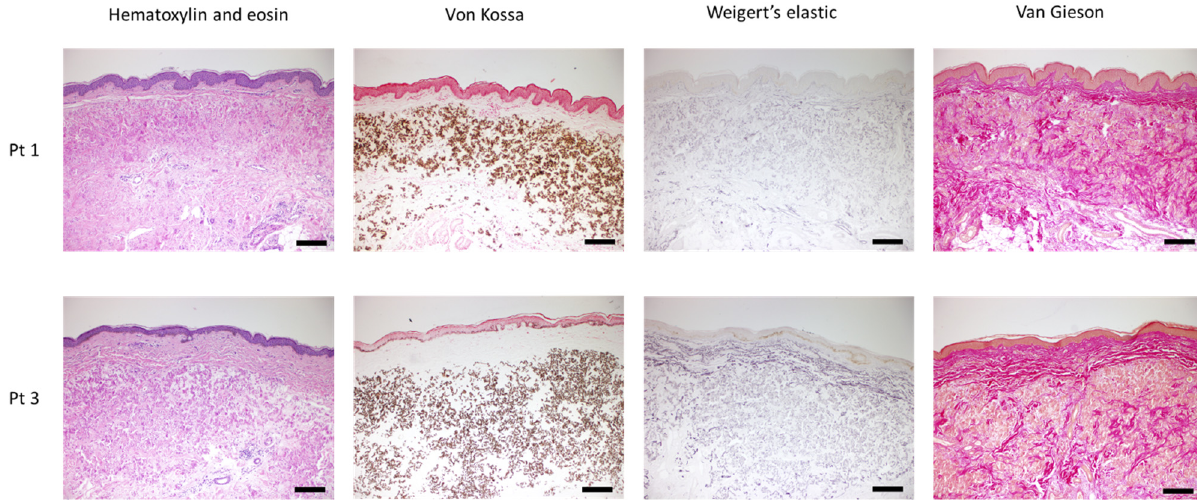
Figure 2. Histopathological characteristics of skin biopsies of the pseudoxanthoma elasticum patients (Pt) with hematoxylin and eosin (H&E), von Kossa (VK) staining for calcium deposits, Weigert’s elastic (WE) staining for elastin and van Gieson (VG) staining for collagen. Scale bars display 100 μ m.